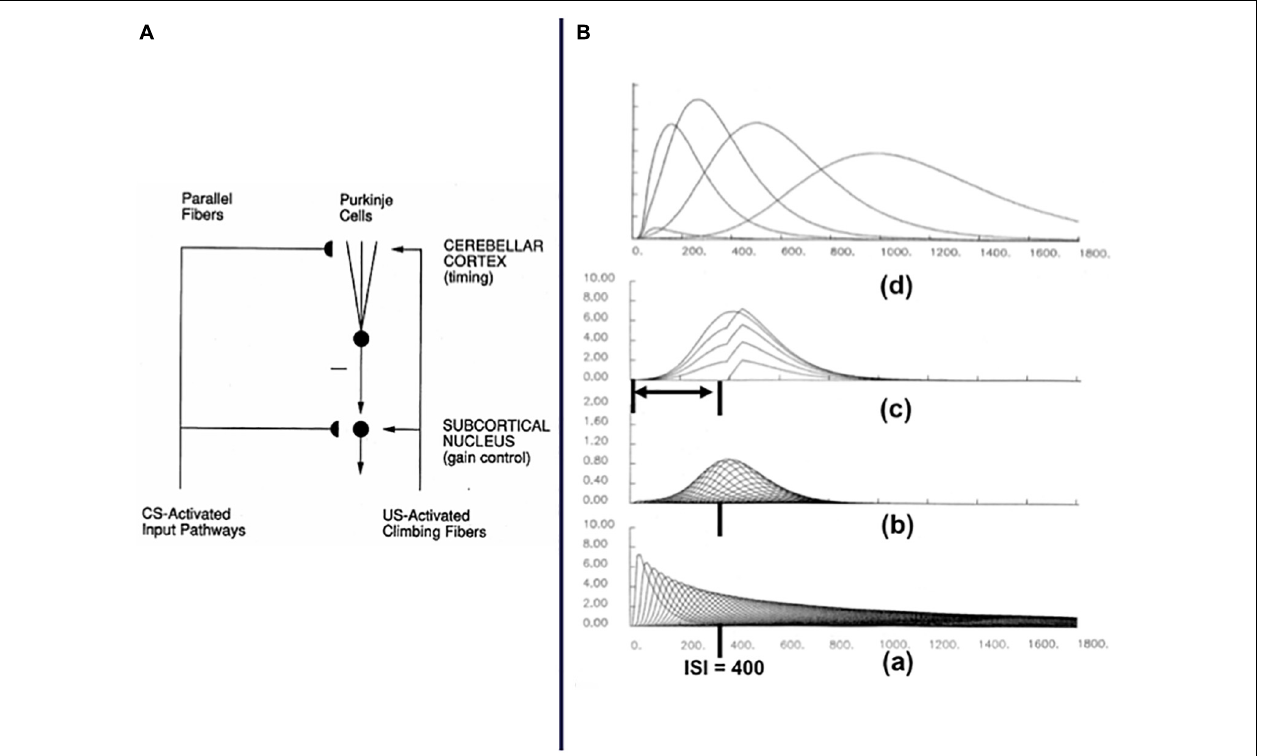
FIGURE 12 | (A) Schematic of how learning in the cerebellum occurs. [Reprinted from Grossberg and Merrill (1996)]. (B) Summary of a computer simulation showing how the cerebellum learns adaptively timed responses over a duration of hundreds of milliseconds using the population response of a tunable spectrum of cells whose individual peak responses occur at different times during this time interval. [Adapted from Grossberg and Schmajuk (1989)]. See the text for